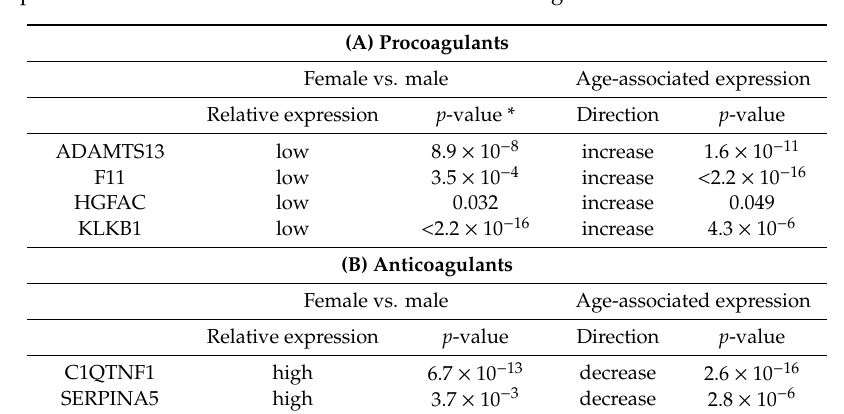
Table 1. Candidate gene products that may be involved in COVID-19-related coagulopathy. Candidates were either ( A ) procoagulants (ADAMTS13, F11, HGFAC, KLKB1), which display a lower expression in femalesthaninmalesandincreasewithage, or( B )anticoagulants(C1QTNF1, SERPINA5), whichdisplay higher expression in females than in males and decrease with